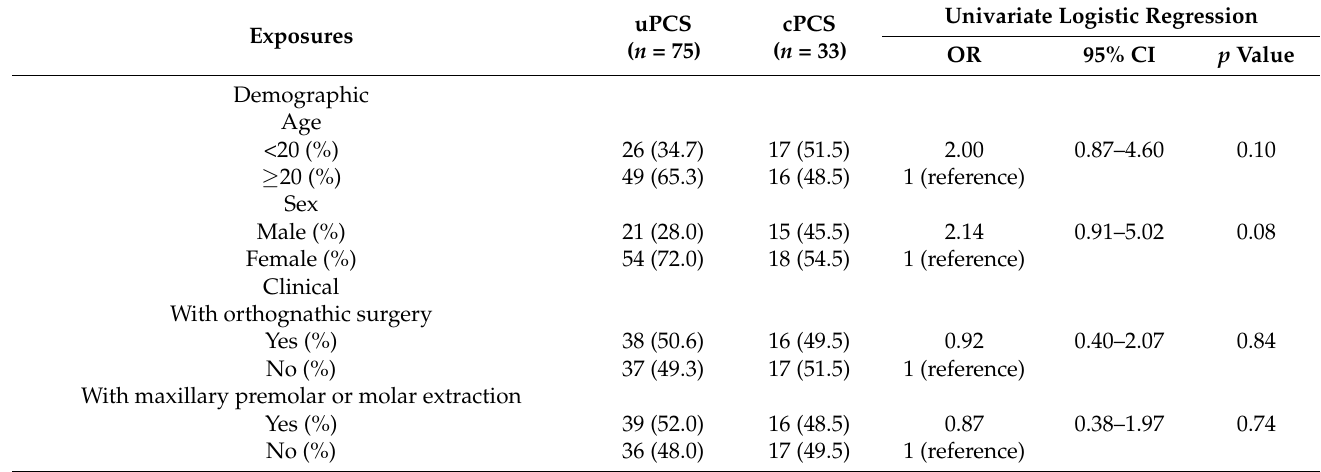
Table 2. Univariate logistic regression analysis in the PCS-unchanged (uPCS) and PCS-changed (cPCS)